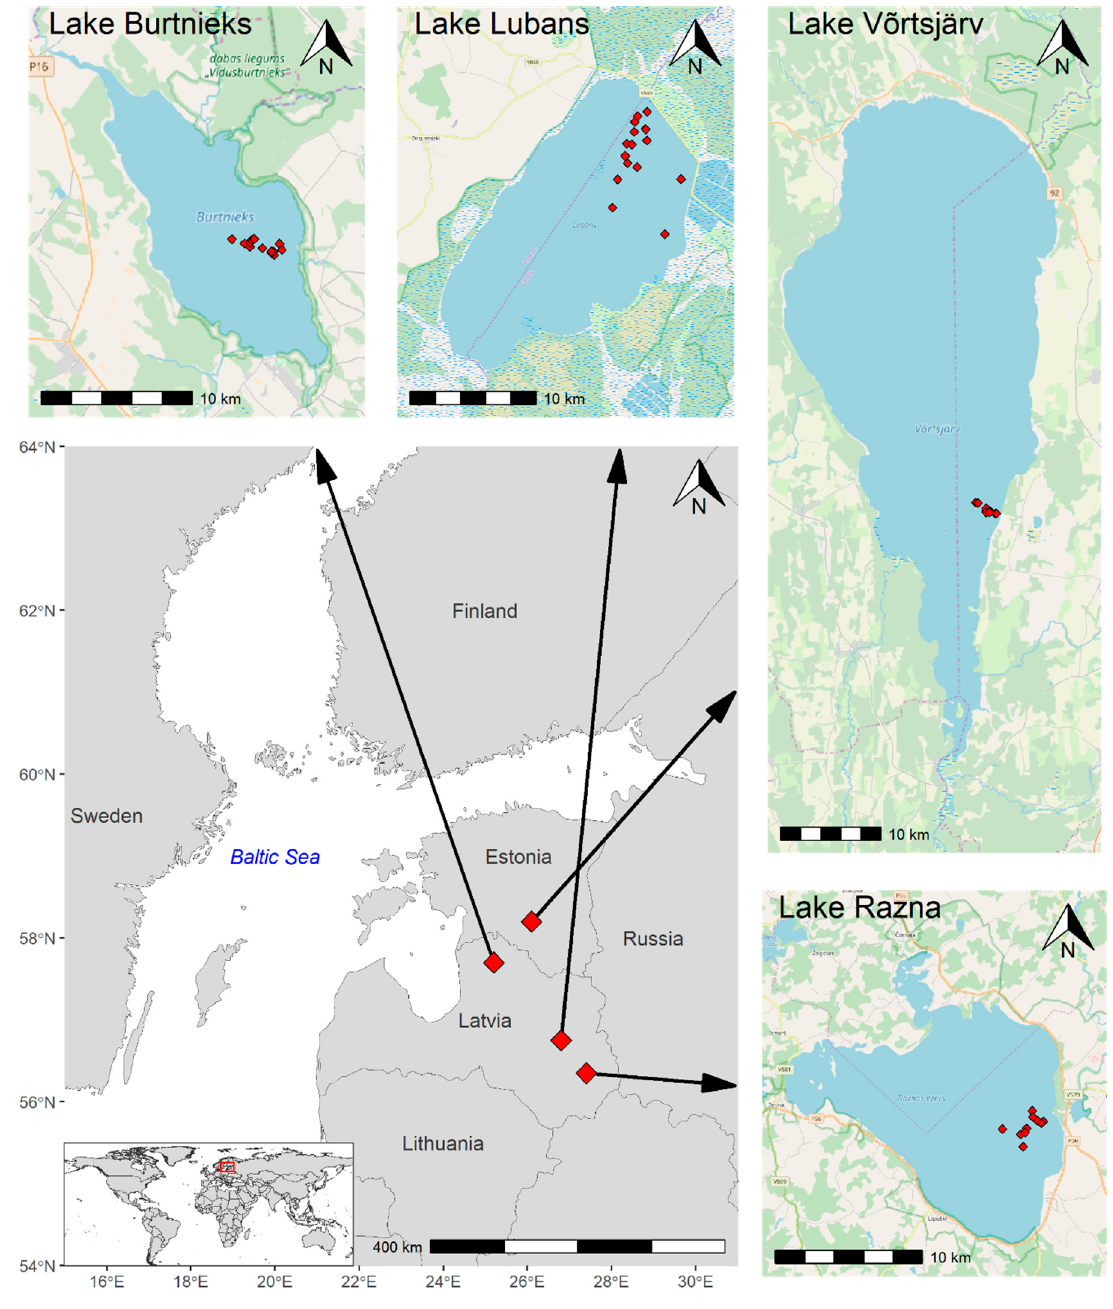
Figure 1. The location of the study lakes and their sampling Figure 1 . The location of the study lakes and their sampling points.